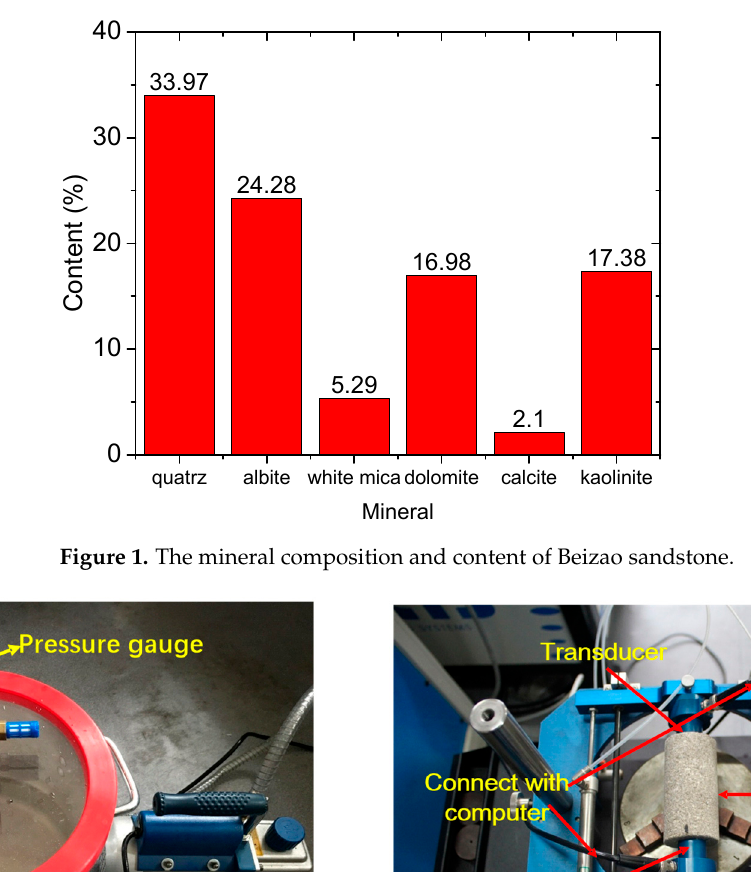
Figure 1. The mineral composition and content of Beizao sandstone.